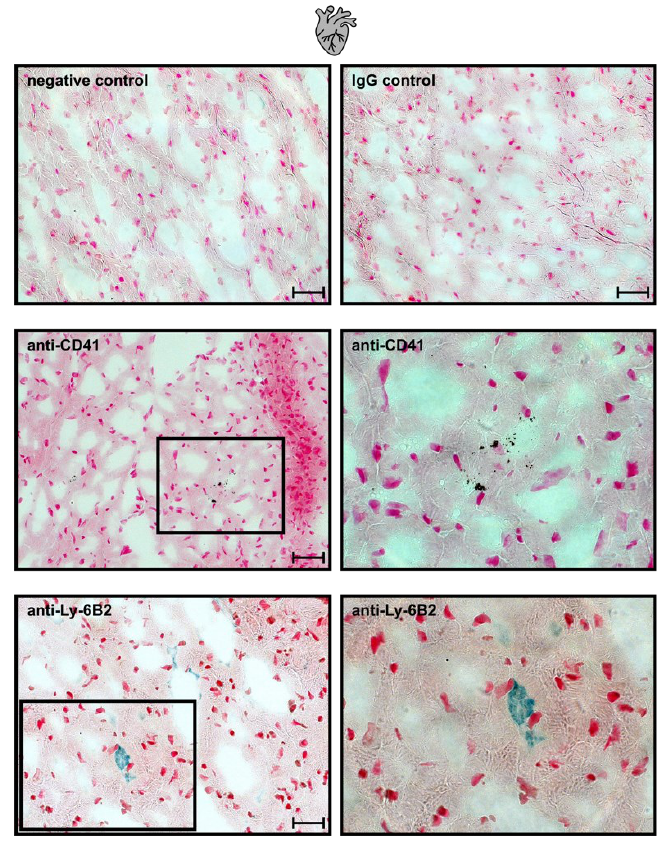
Figure A7. Immunohistological staining of infarcted heart tissue . Structural staining of organ cells was achieved by nuclear fast red. Immunohistological isotype and secondary antibody control staining (nuclear fast red stained without anti-CD41 or anti-Ly-6B2). Scale bars 10 µm. Representative single staining of platelets (anti-CD41) and neutrophils (anti-Ly-6B2), as indicated. Right panels are 2.5× magnifications of the corresponding left panels . Representative images of n = 3 mice are shown.